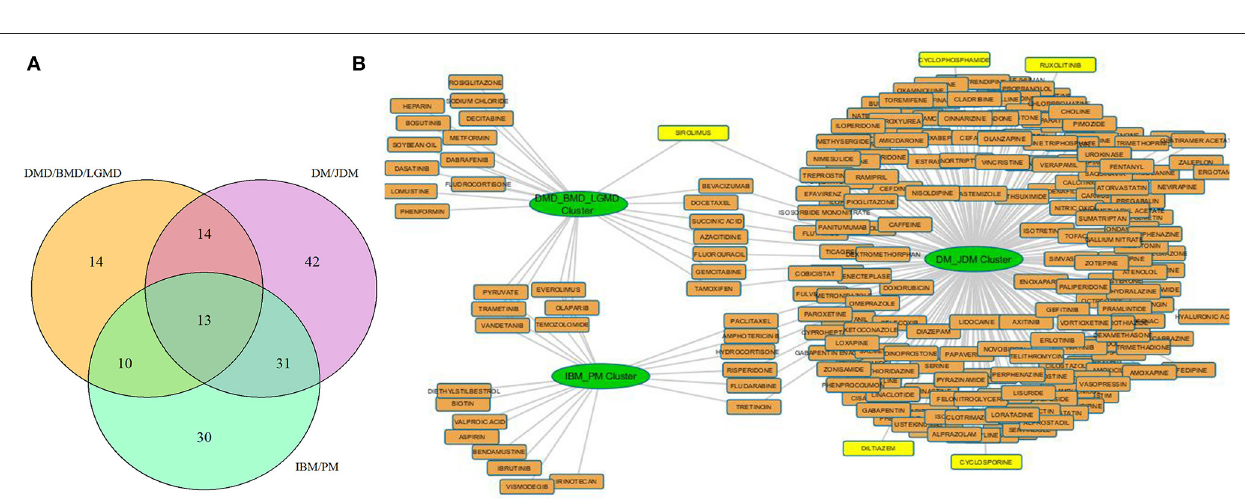
FIGURE 4 | The Ca 2 + homeostasis associated functional module in ALS and CP. This figure captures the calcium dysregulation mechanisms (and difference between ALS and CP) via the fold changes associated with select genes of the Ca 2 + homeostasis functional module. The left half indicates the fold change associated with ALS while the right half indicates the fold change associated with CP.